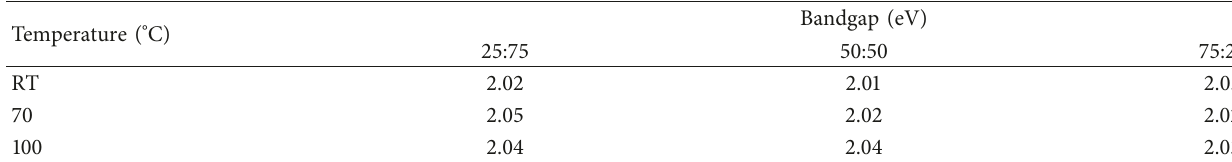
Table 2: Bandgap variation of InSe with different annealing temperatures.